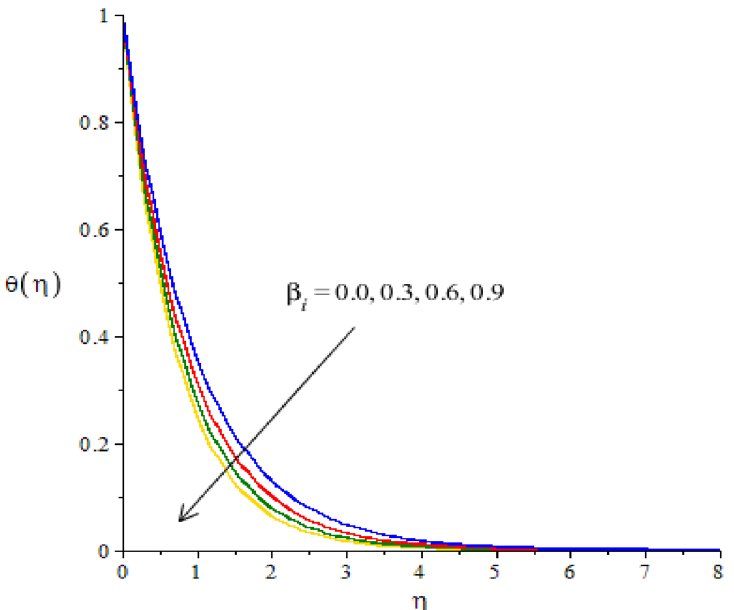
Figure 9. The graphical view of temperature versus β i